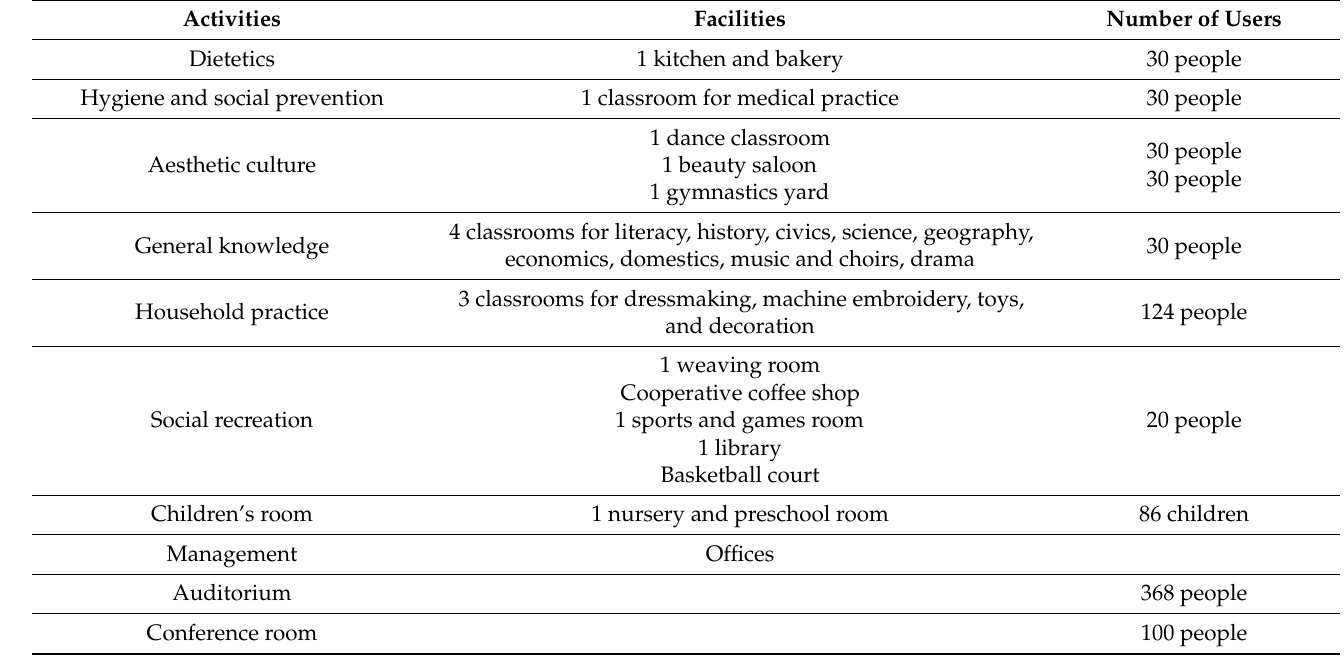
Figure 5. Activities offered by the Casas de la Asegurada, according to the Programs of Cultural, Social, and Artistic Activities of the Casa de la Asegurada of the IMSS. Source: own creation based on the drawings of [11], 2021. Table 4. Programs and facilities of a Casa de la Asegurada per 2500 members according to